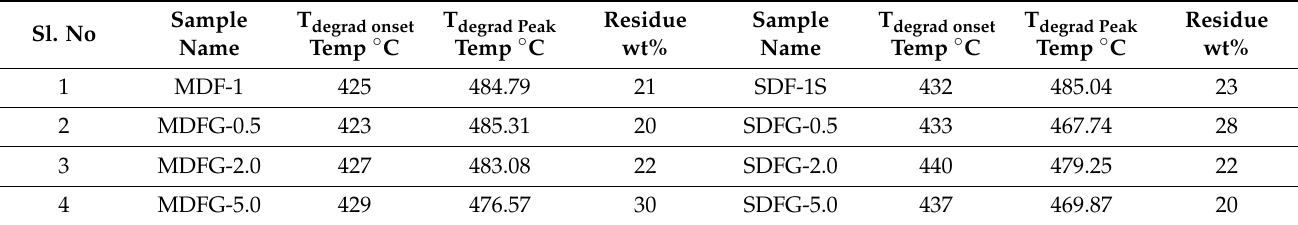
Table 3. Summary of Thermal Degradation